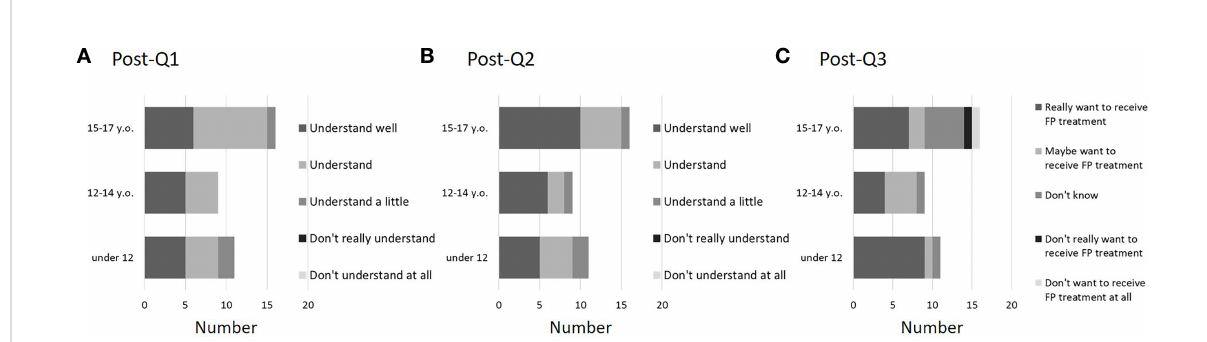
FIGURE 4 Questionnaire results after FP explanation (post-Q1, 2, and 3). A certain degree of understanding was reported, and no patients reported no understanding at all of the effects of treatment on fertility or of FP treatment ( A : post-Q1; B : post-Q2). In addition, two participants aged 15 – 17 answered that they did not want to undergo FP, but one (a boy) subsequently decided to undergo sperm cryopreservation. The other (a girl) did not meet the indications for FP ( C : post-Q3). Of these 36 patients, 11 were <11 years old (Group A), 9 were 12 – 14 years old (Group B), and 16